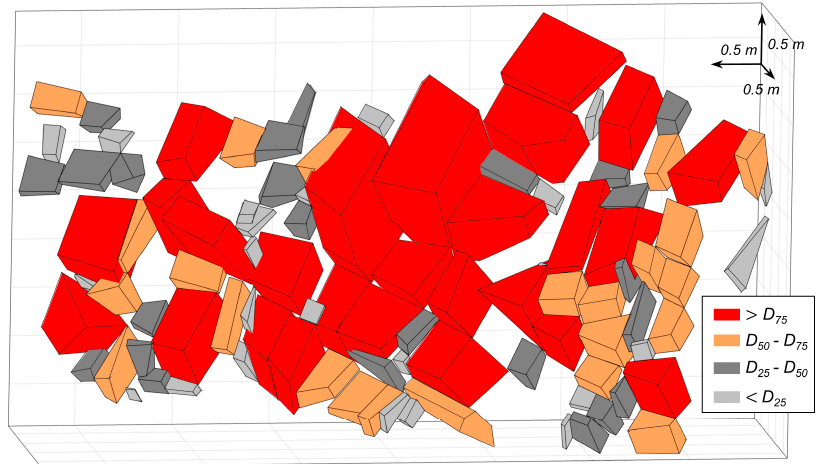
Figure 13. The EBSD D of rock blocks extracted from PCM-DDN of Site 1.